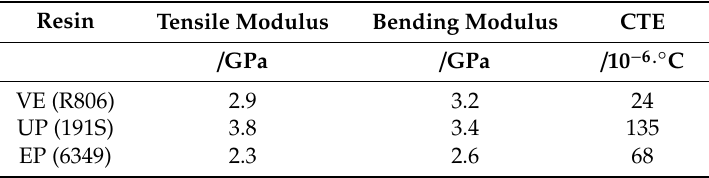
Table 3. Specification of resins.